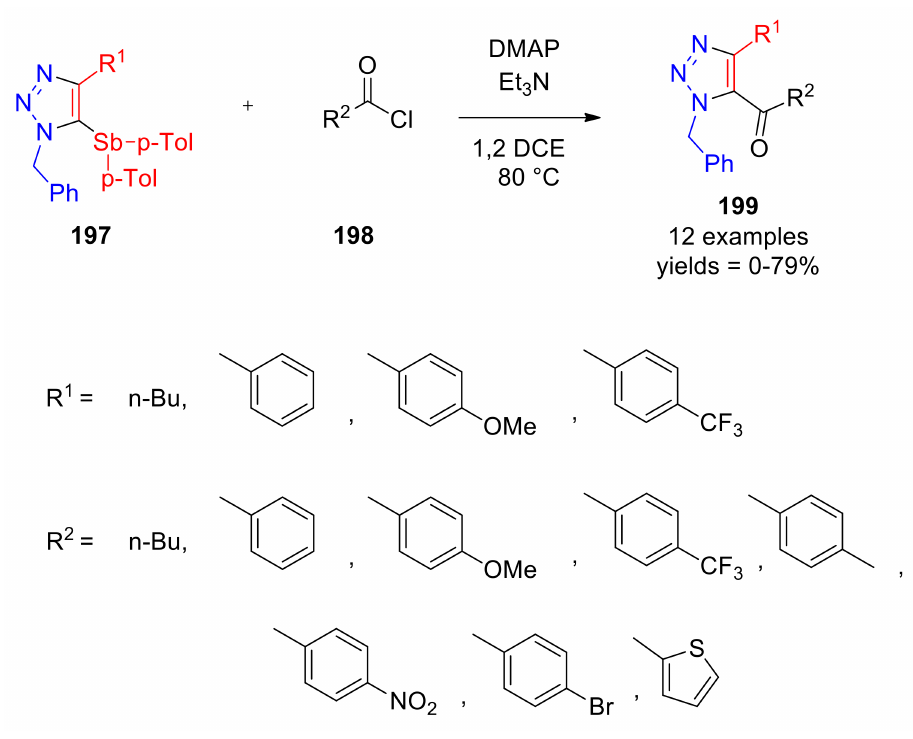
Scheme 65. Synthesis of trisubstituted 5-acyltriazoles 199 .